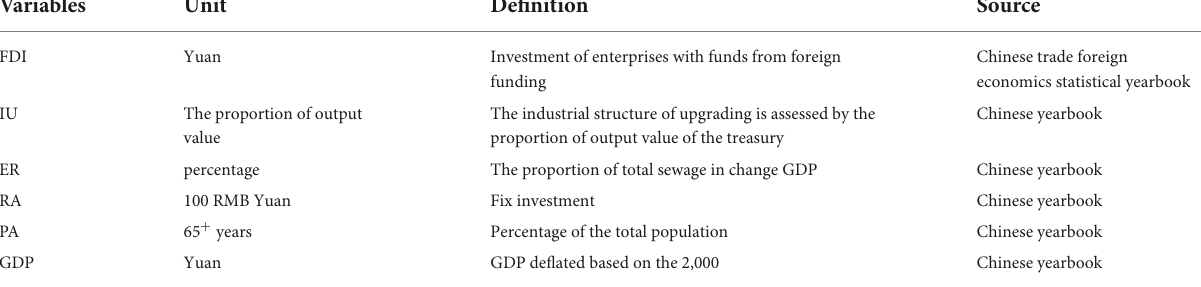
TABLE 1 Variable description and data